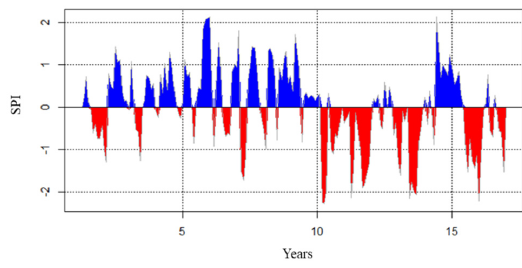
Figure 10. Four ‐ month SPI (years: 2000–2015). Figure 10. Four-month SPI (years: 2000–2015). Figure 10. Four-month SPI (years: 2000–2015).